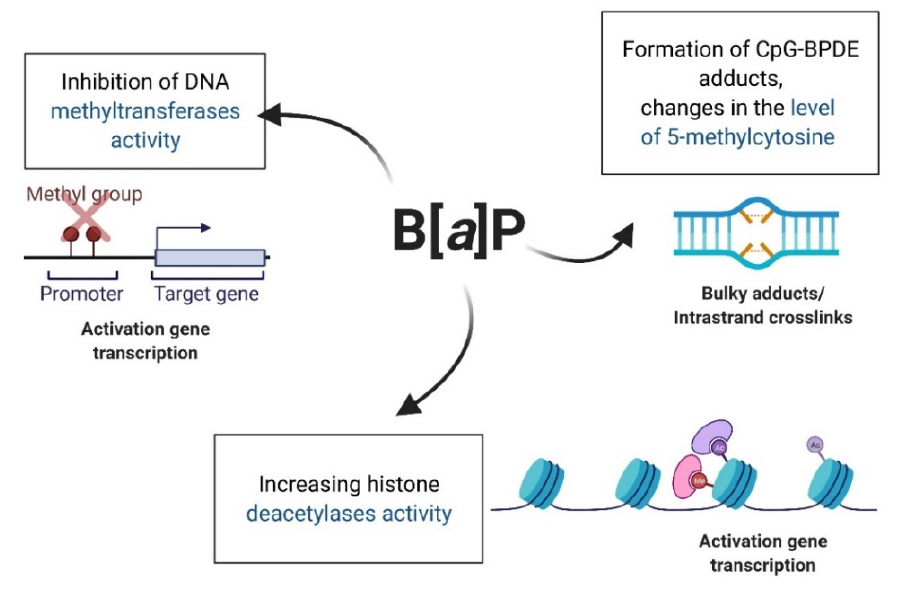
Figure 8. Mechanism of epigenetic changes induced by B[ a ]P. Created with BioRender.com (accessed on 12 April 2022).